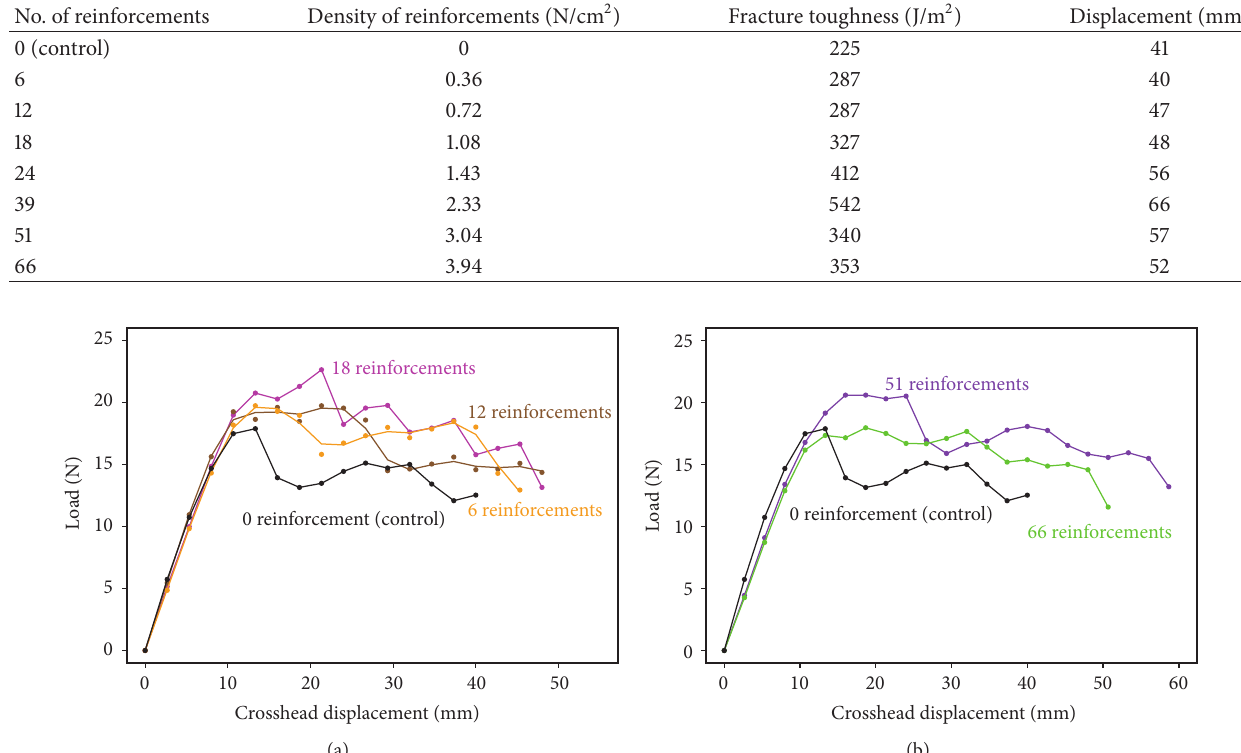
Figure 9: Load-displacement curves during double cantilever beam (DCB) mode I fracture toughness tests of specimens with 6 different levels of through-reinforcement (including the control): (a) reinforcement levels less than 24 ( < 1.43/cm 2 ); (b) reinforcement levels greater than 39 ( > 2.33/cm 2